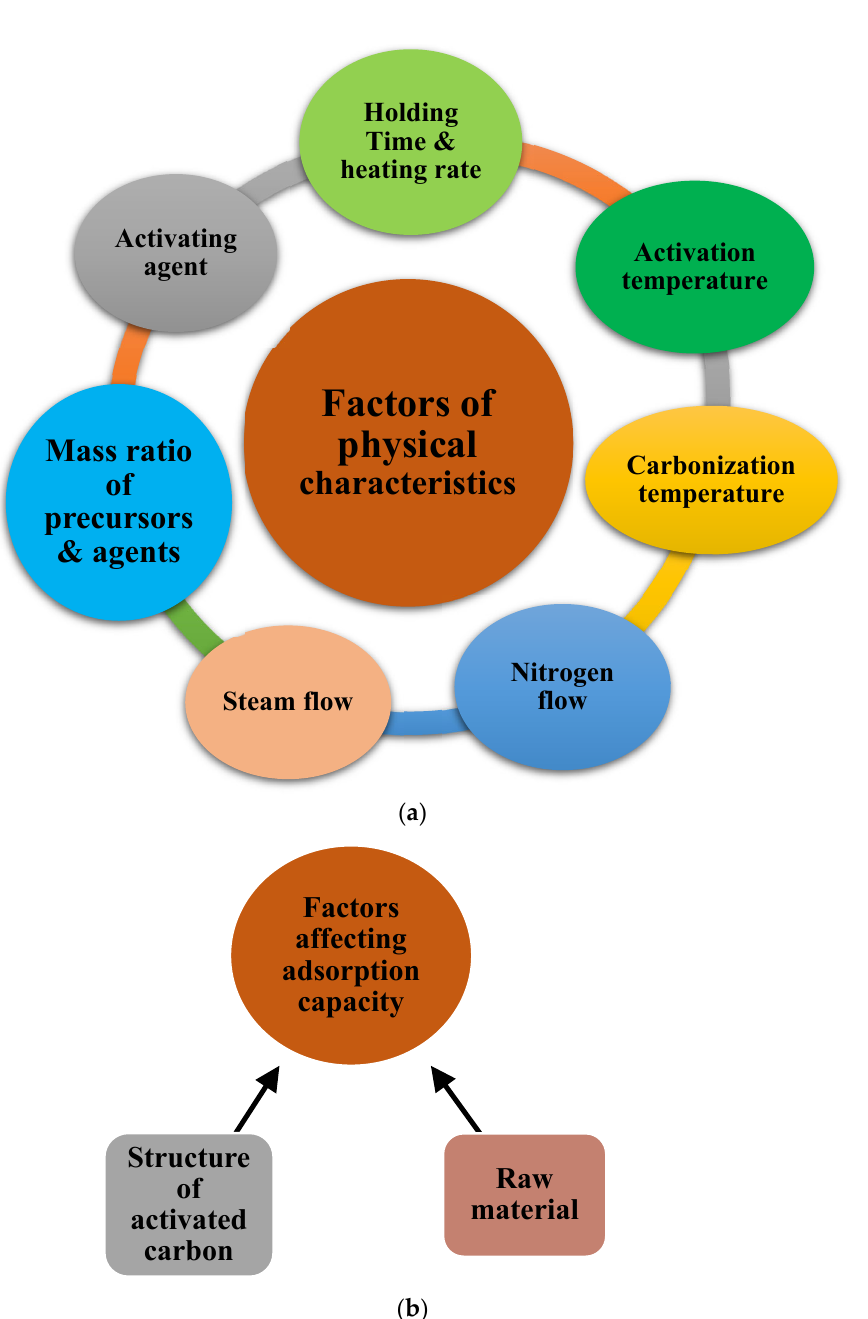
Figure 9. Factors influencing the ( a ) physical characteristics and ( b ) adsorption capacity.